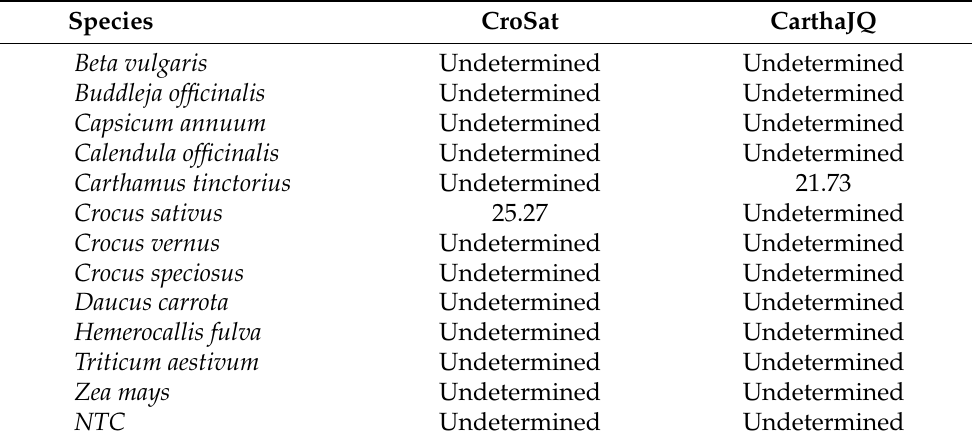
Table A1. Results of the specificity tests for the ‘Crosat’ and ‘CarthaJQ’ assays. Each column lists the corresponding C q value obtained on approximately 18 ng of template